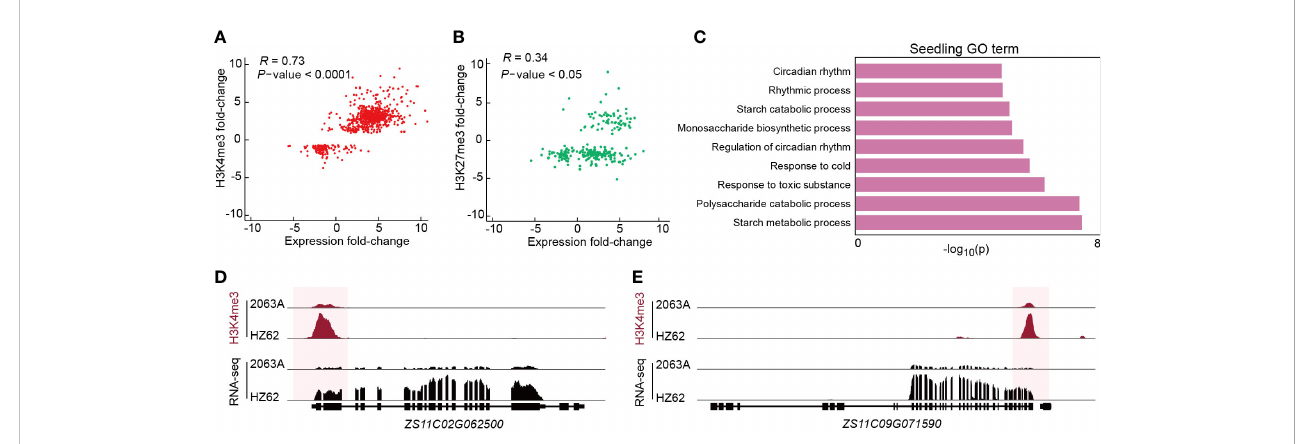
FIGURE 4 (A, B) Correlations between differential histone modi fi cation (FDR < 0.05, log2 (fold change) > 1 or < – 1) and gene expression (FDR < 0.05, log2 (fold change) > 1 or < – 1). The statistical analysis wad performed using the t-test. (C) Enriched GO terms of genes associated with differentially H3K4me3- modi fi ed regions between HZ62 and 2063A in seedling. (D, E) Genome browsers of differentially H3K4me3-modi fi ed regions and expressed genes in HZ62 and